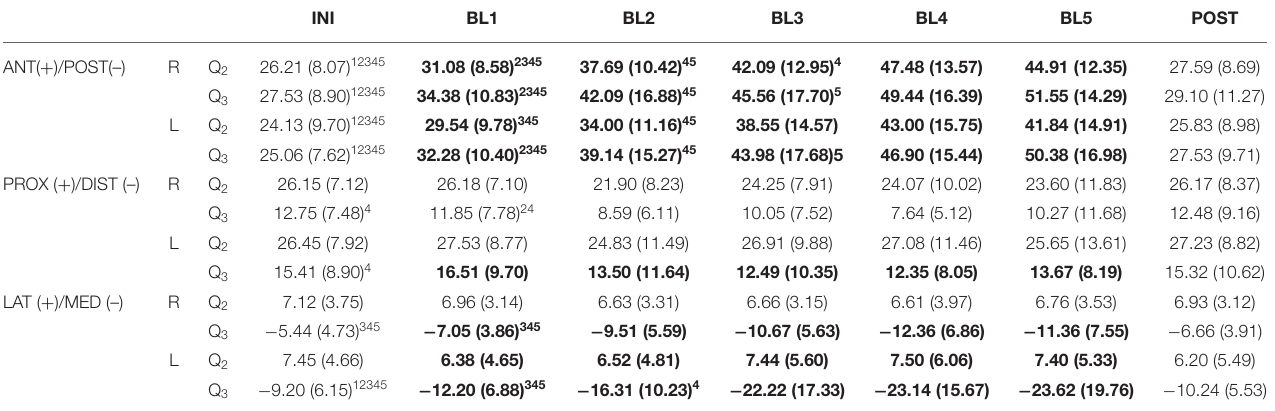
TABLE 4 | Average (1 SD) bilateral shoulder joint force components in N.m during Q 2 and Q 3 .